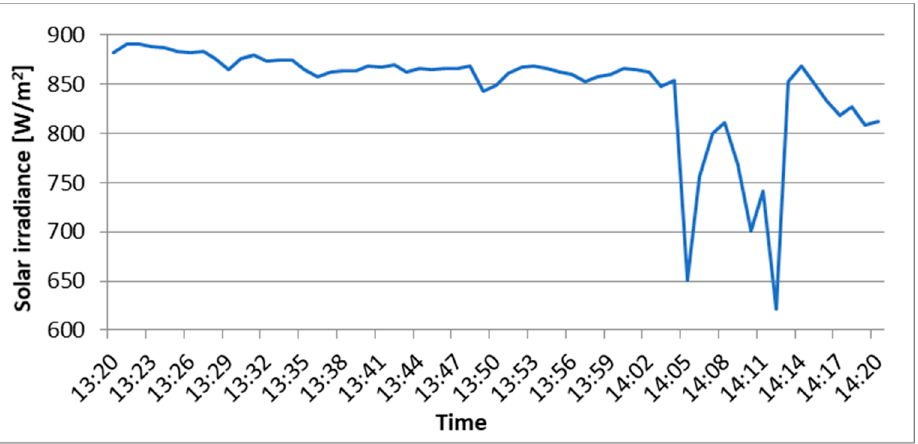
Figure 10. Solar irradiation during the maximal power test.